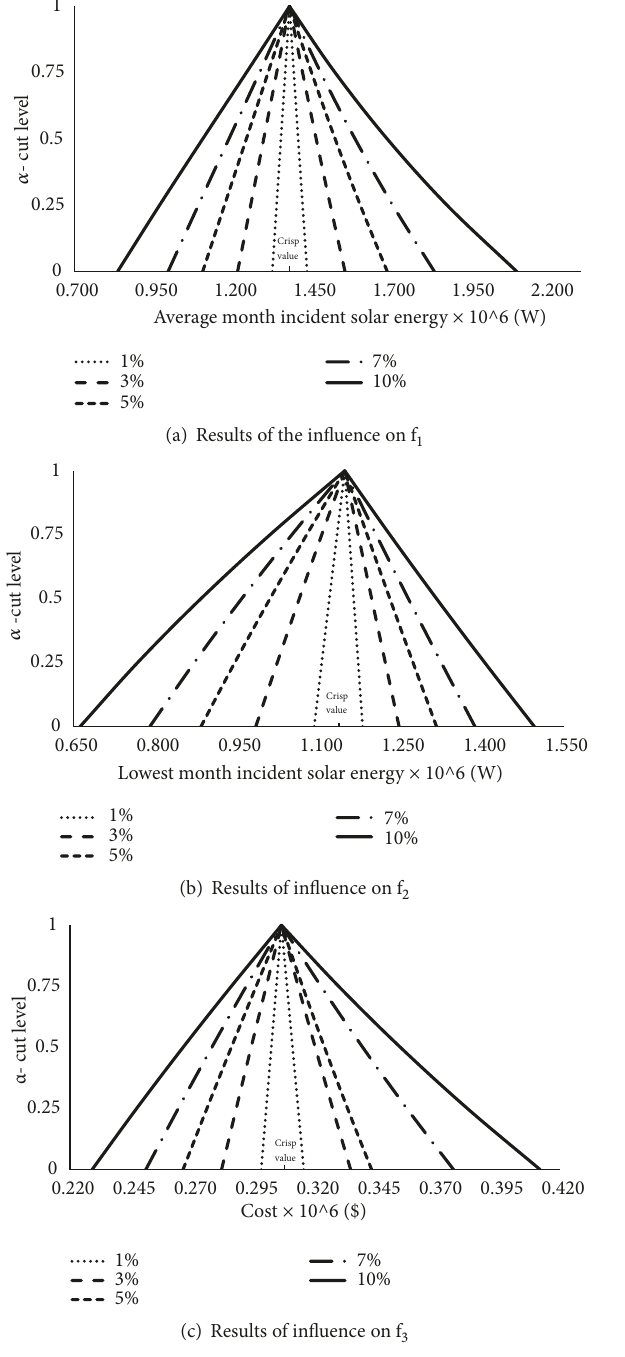
Figure 6: Variation of triangular shapes of f 1 , f 2 , and f 3 with respect to a fuzzy set interval confidence.